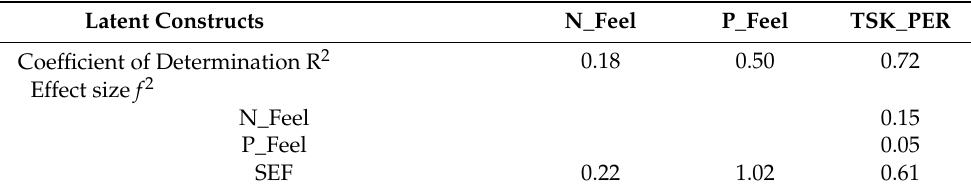
Table 9. Coefficients of determination R 2 and effect size f 2.